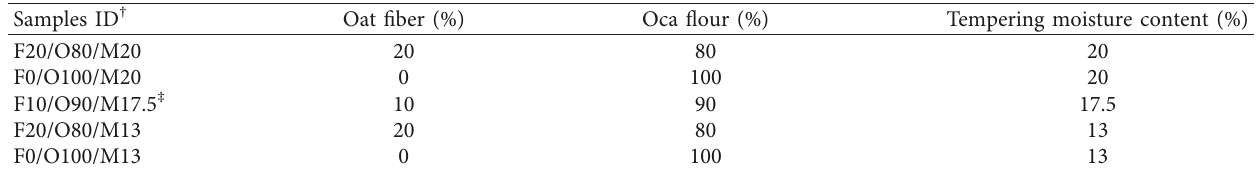
Table 1: Experimental design with different levels of oat fiber and oca flour used to obtain collets extruded at different tempering